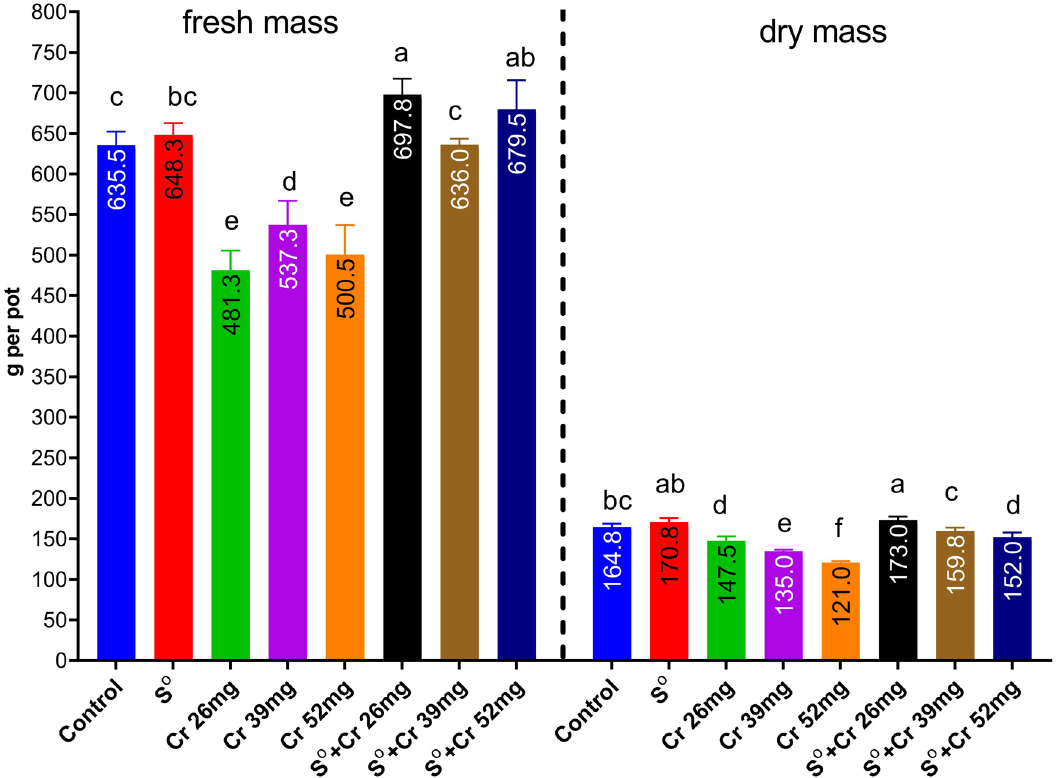
Figure 1: Yield of